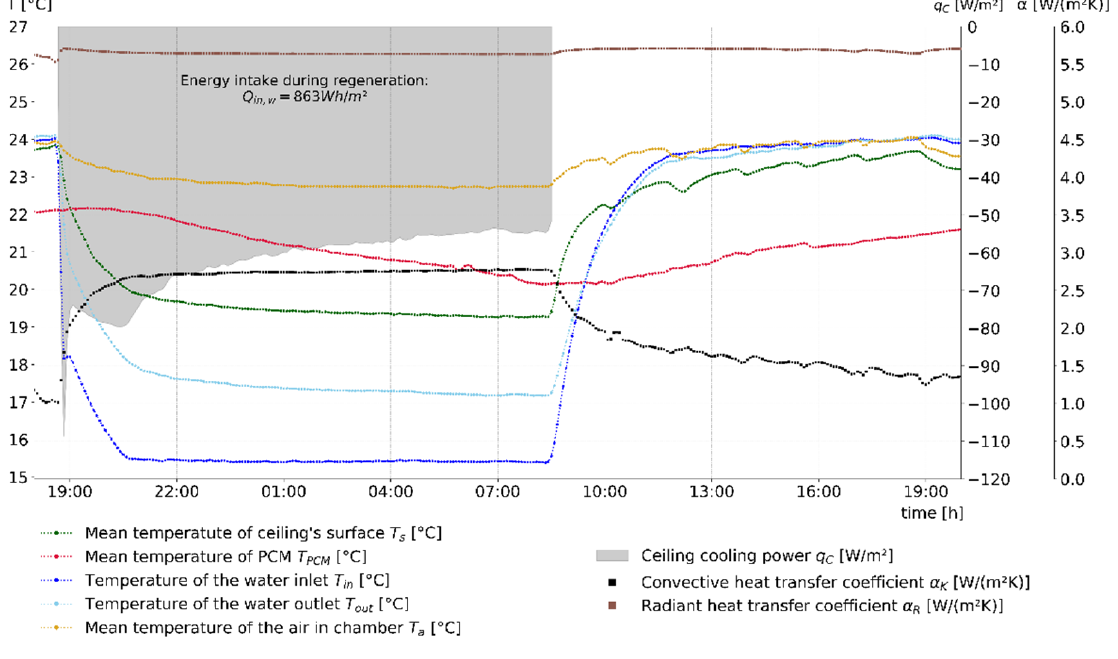
Figure 8. Experimental results for variant IIa.